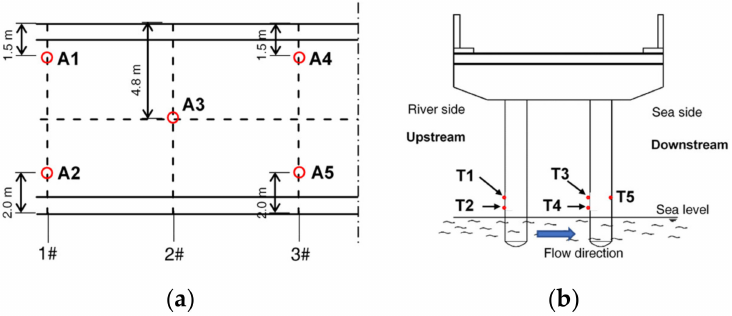
Figure 2. Locations of concrete samples: ( a ) Bridge deck; ( b ) Pier